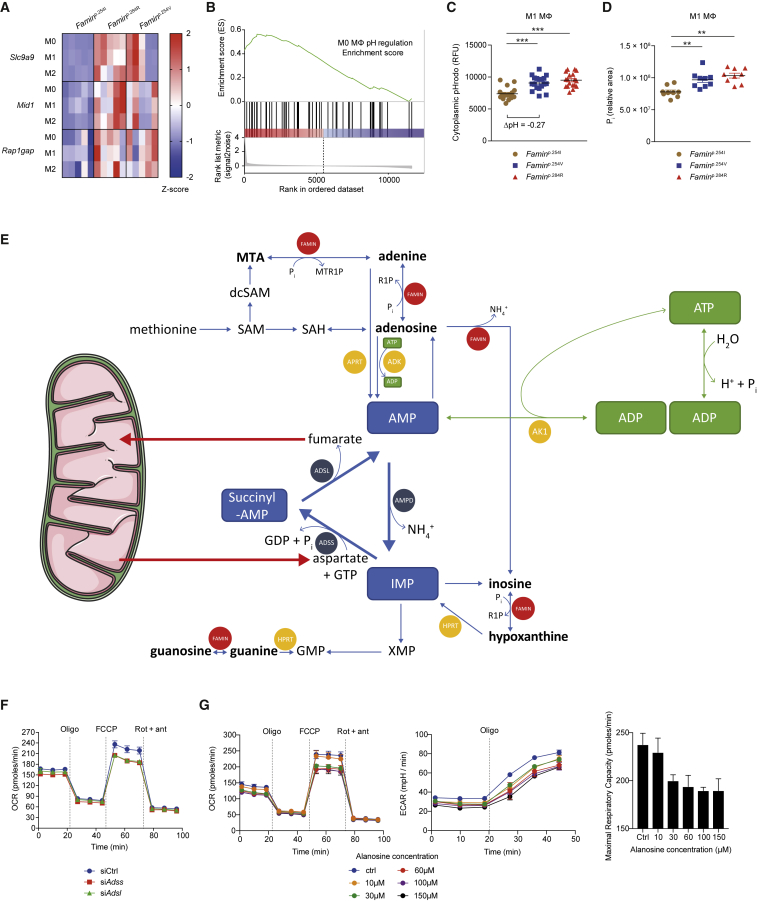
FAMIN Activity Controls Cellular pH and Enables a Purine Nucleotide Cycle(A) Heatmap of differentially expressed genes by Famin genotype in M0, M1, and M2 macrophages (n = 5).(B) Gene set enrichment analysis in Faminp.254I compared to Faminp.284R M0 macrophage transcriptomes; Gene Ontology pH regulation gene set (n = 5).(C) Cytoplasmic pH measured by pHrodo in M1 macrophages (n = 18).(D) Inorganic phosphate levels in M1 macrophages (n = 9).(E) Schematic of the purine nucleotide cycle (PNC; blue boxes and circles) with phosphorolysis, deamination, and salvage routes involving FAMIN. AMPD, AMP deaminase; ADSS, adenylosuccinate synthase; ADSL, adenylosuccinate lyase; AK1, adenylate kinase.(F) Oxygen consumption rate (OCR) of Faminp.254I M0 macrophages silenced for Adsl or Adss or transfected with siRNA control. Basal OCR followed by (dotted vertical lines) oligomycin A (Oligo), FCCP, and rotenone plus antimycin A (Rot + ant) (n = 3).(G) OCR (left), extracellular acidification rate (ECAR) (middle), and maximal respiratory capacity (right) of Faminp.254I M0 macrophages treated with L-alanosine. (n = 3).Data represented as mean ± SEM. ∗p < 0.05, ∗∗p < 0.01, and ∗∗∗p < 0.001 (one-way ANOVA).